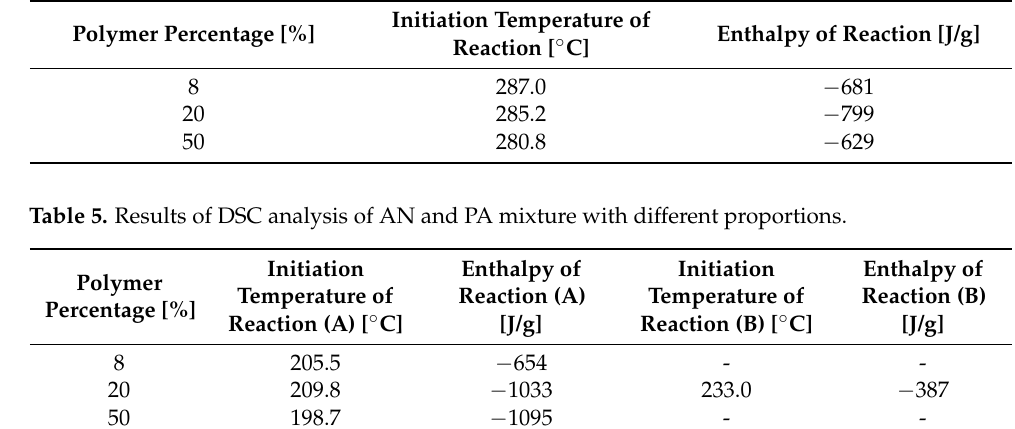
Table 4. Results of DSC analysis of AN and soft PMMA mixture with different proportions.